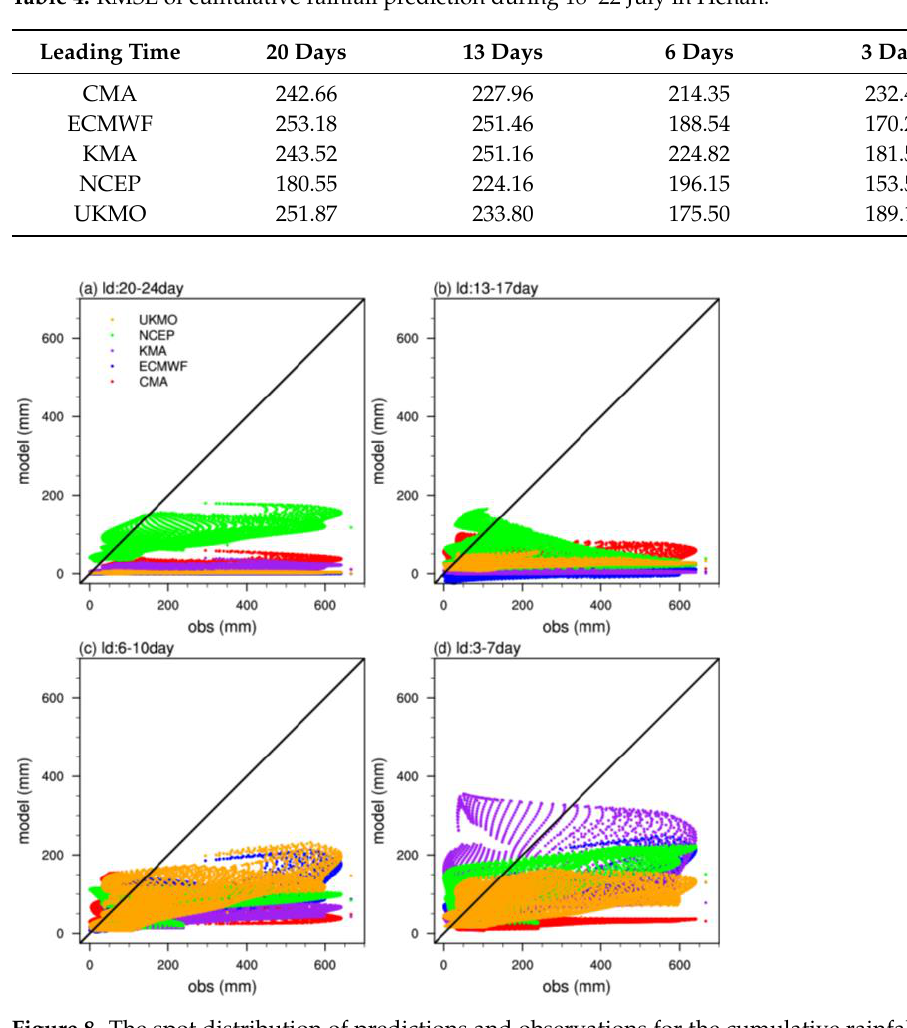
Figure 8. The spot distribution of predictions and observations for the cumulative rainfall during 18–22 July 2021 in Henan. Prediction ( a ) 20 days, ( b ) 13 days, ( c ) 6 days, and ( d ) 3 days in advance.